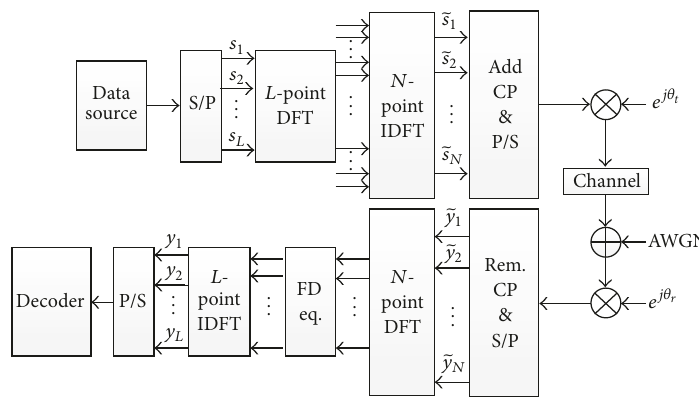
Figure 1: Block diagram of the discrete baseband SC-FDMA